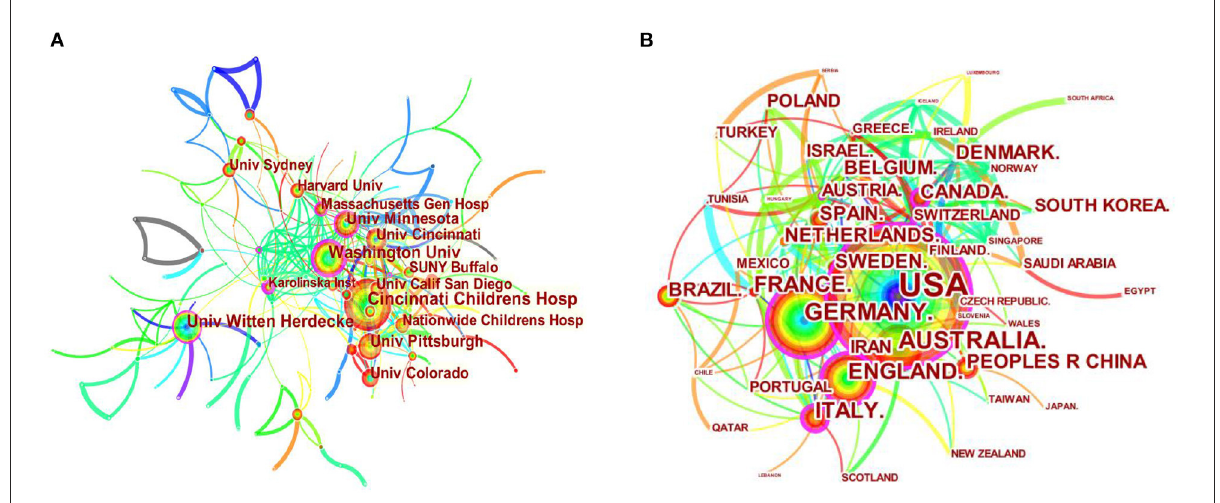
FIGURE3 The institution collaboration network in the research of WLOCA (A) ; Co-country/region distribution network in the research of WLOCA (B)